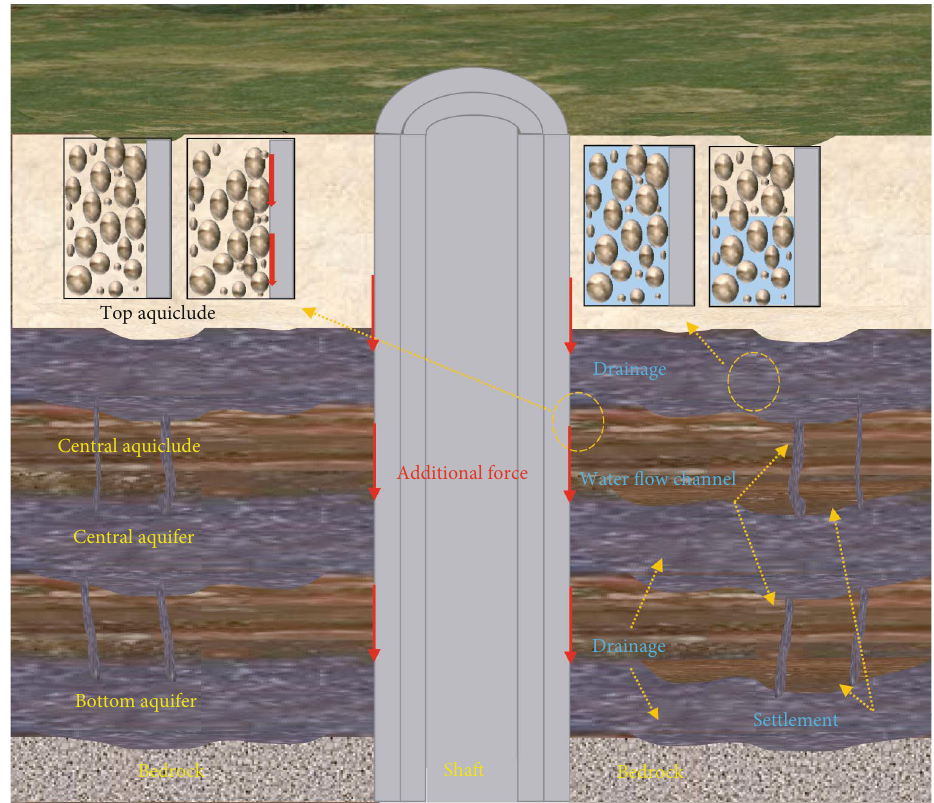
Figure 1: Additional force induced by settlement of topsoil containing